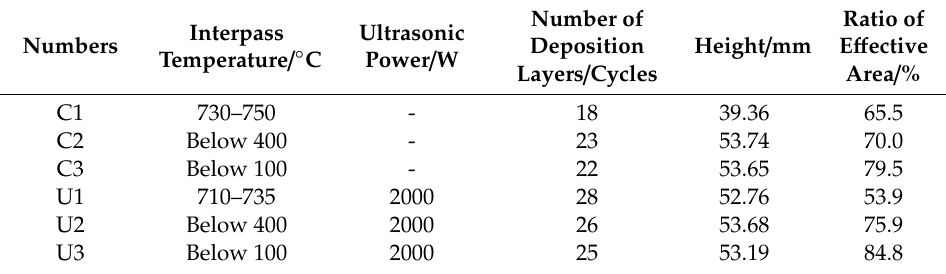
Table 1. The nomenclature and processing parameters of the